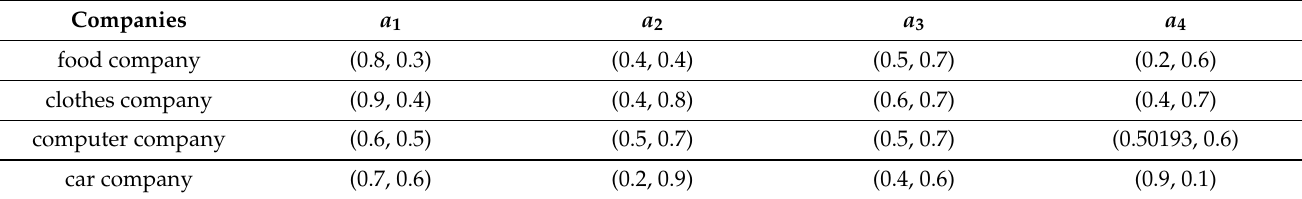
Table 1. ( m , n ) -Fuzzy